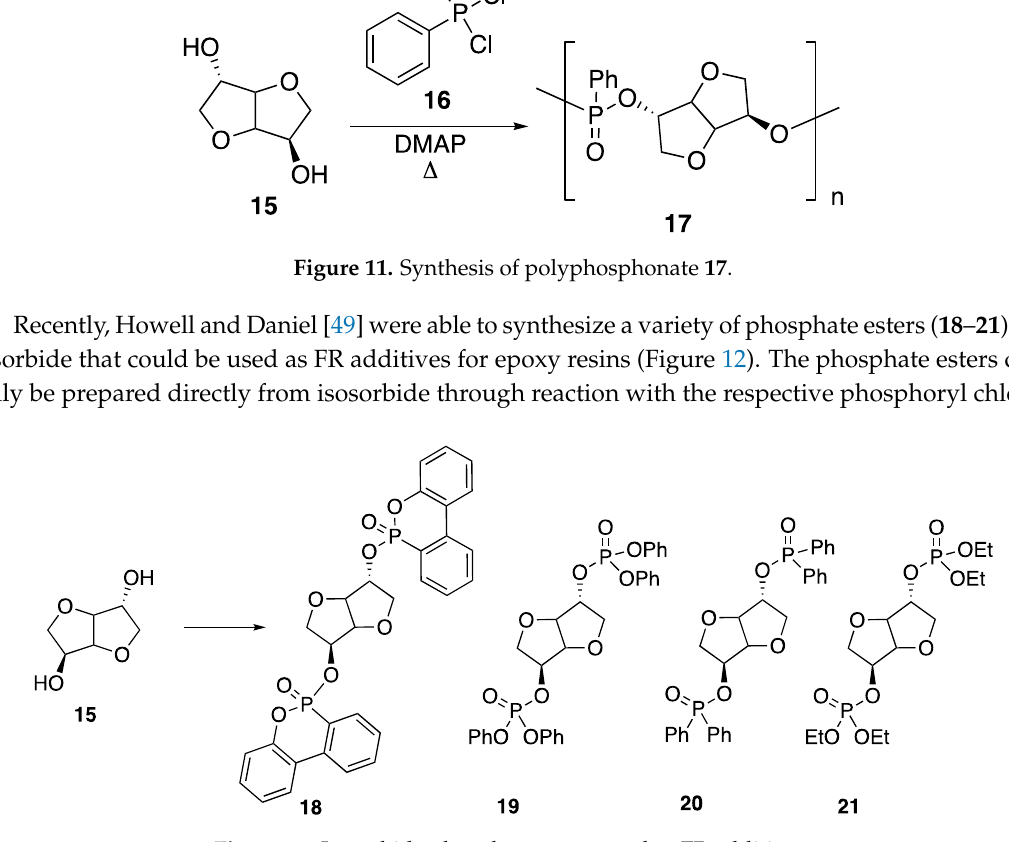
Figure 13. Preparation of FR epoxy resins from 22 and 23 containing 18 , 19 , 20 , or 21 . 2.4. Diphenolic Acid